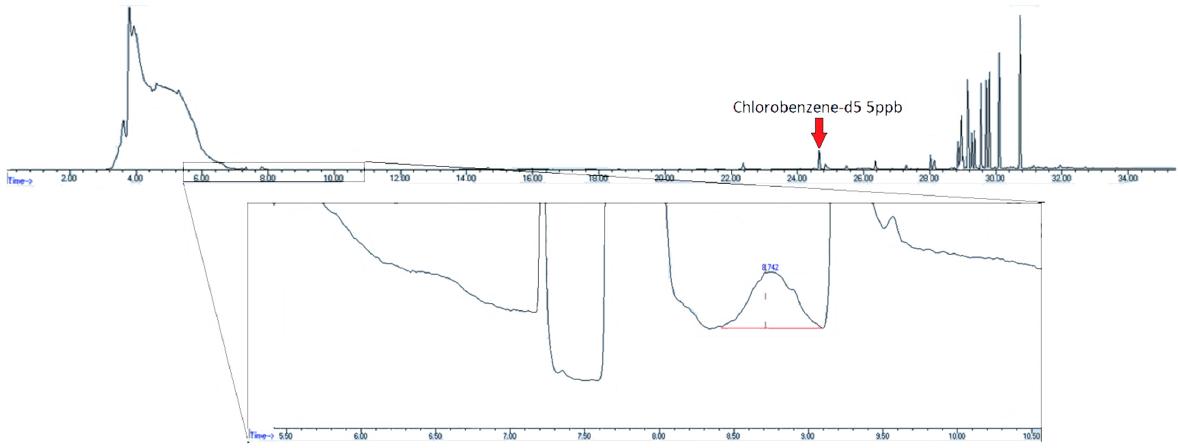
Figure 7. Chromatogram of contaminated air canister post standard canister cleaning with standard evacuation/pressuri- Figure zation cycle. Insert–SIM trace of m / z 29. EtO concentration–5.9 ppbv.